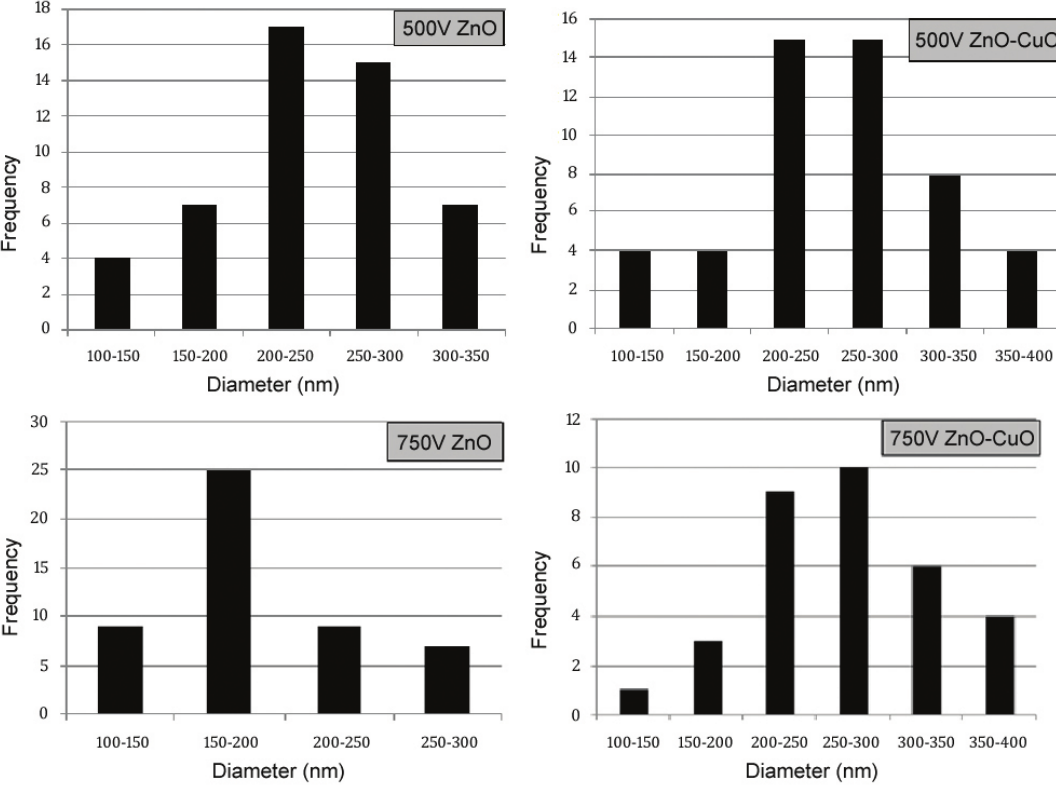
Figure 7. Histogram of particle size of the